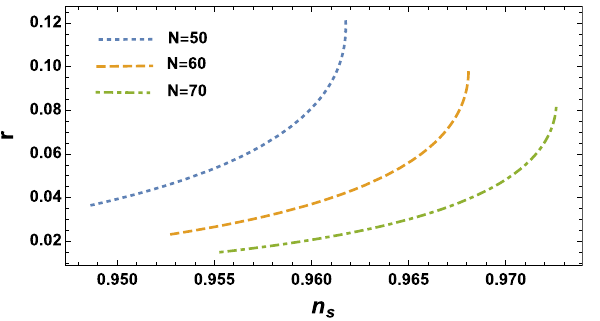
Fig. 7 n s vs r for β in the interval 10 8 ≤ β ≤ 10 9 for N = 50 , 60 , 70 and φ 0 = 10 − 3 M p . Note that larger number of e -folds moves r well inside the region quoted by latest observations